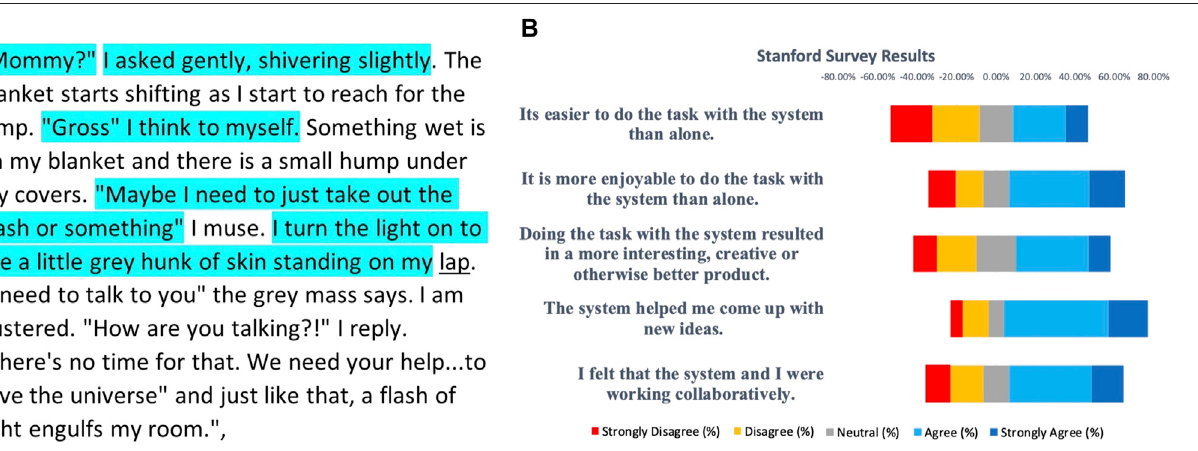
FIGURE 9 | (A) Final story generated by the Writing with Arti fi cial Intelligence system, where turquoise shading represents system suggestions selected by the human partner and present in the fi nal story, and underlining indicates word substitution by the human partner. (Hallmark MC-6: The machine makes meaningful contributions to the interaction. ) (B) Chart of participant survey